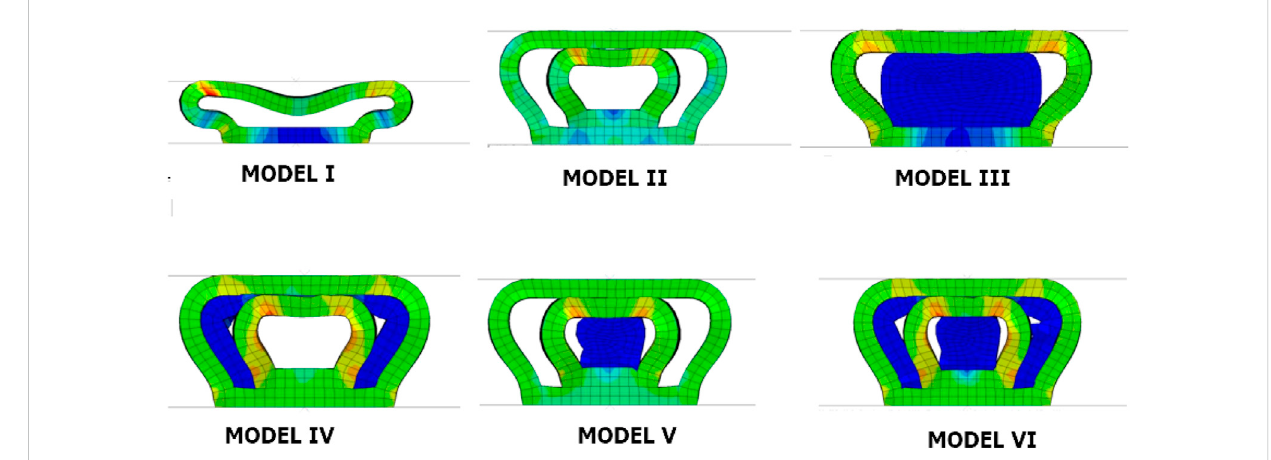
FIGURE 13 Deformation pattern of different structures under dynamic respon.